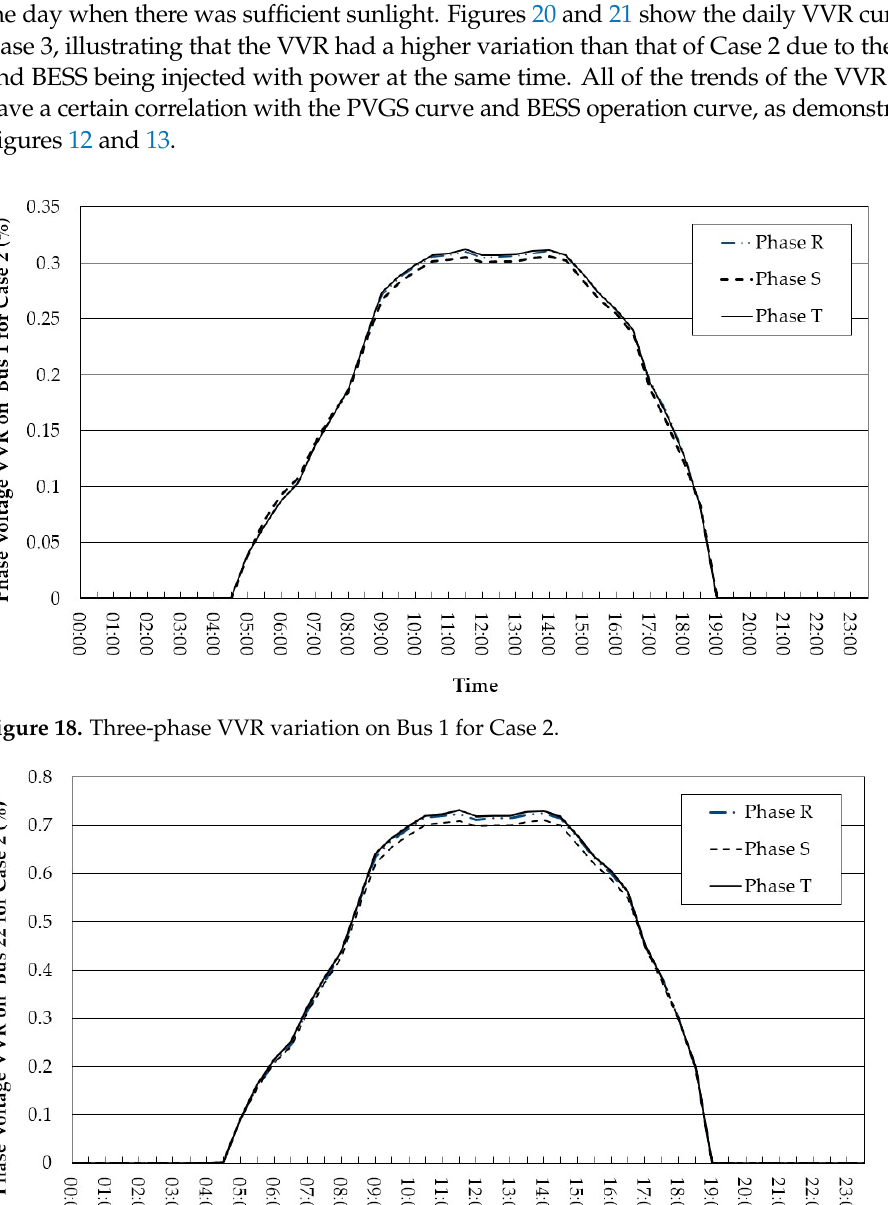
16 of 23 Figure 17. Voltage variation on Bus 22 for Case 1 and Case 3.